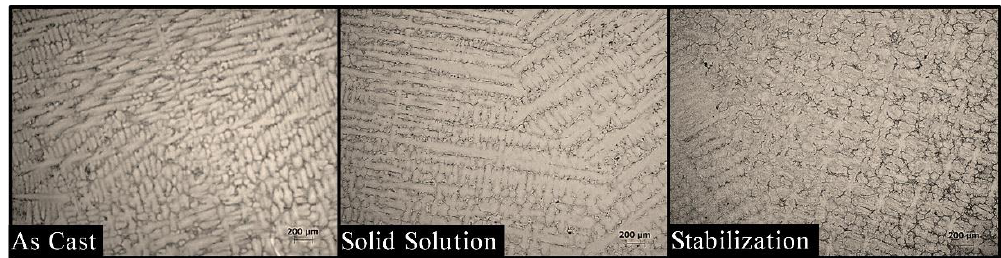
Figure 3. Images obtained by optical microscopy of the Inconel 713C material as cast, solid solution heat treated and stabilization heat treated condition.